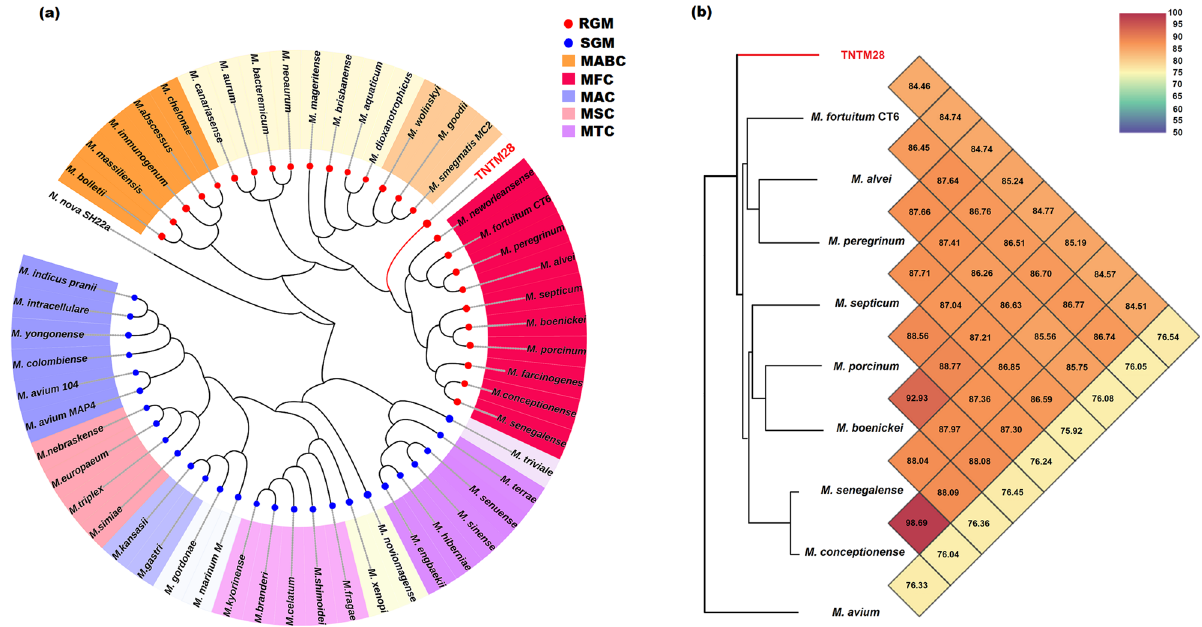
Figure 4. Phylogenomic of TNTM28. ( a ) Phylogenomic tree based on Mauve alignement identity matrix. ( b ) Heatmap generated with OrthoANI values of TNTM28 strain and other closest species of the M . fortuitum